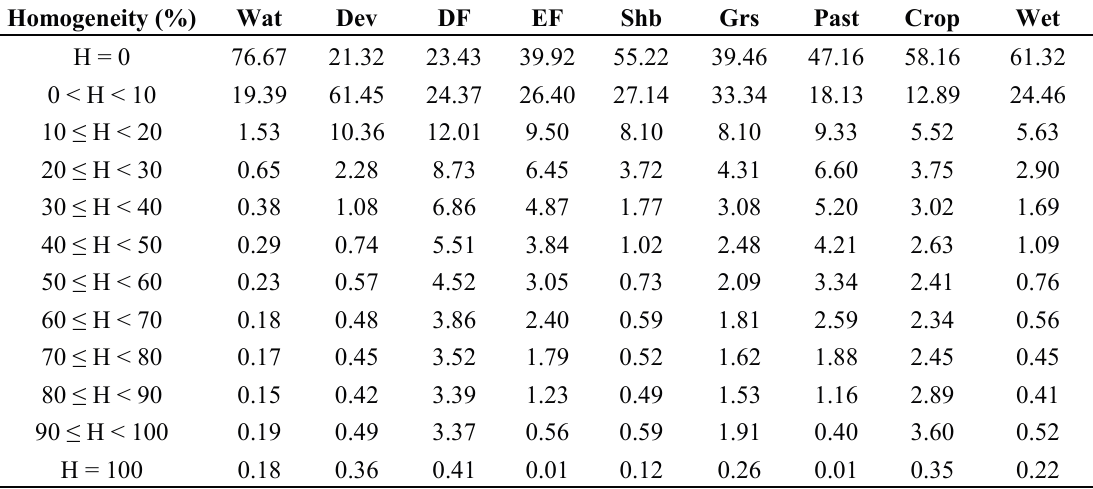
Table 3. Homogeneity (H) in 10-percent bins and bins for 0 and 100 percent derived from NLCD2006. For abbreviations of class names see Table 1.